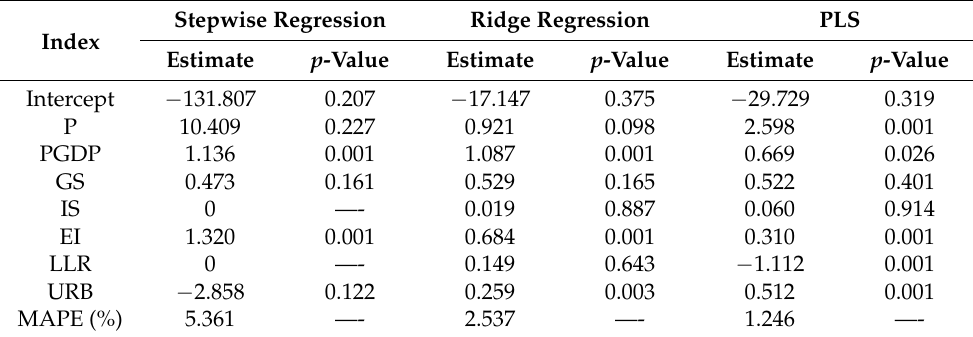
Table 6. The regression coefficients results and mean absolute percentage error (MAPE)